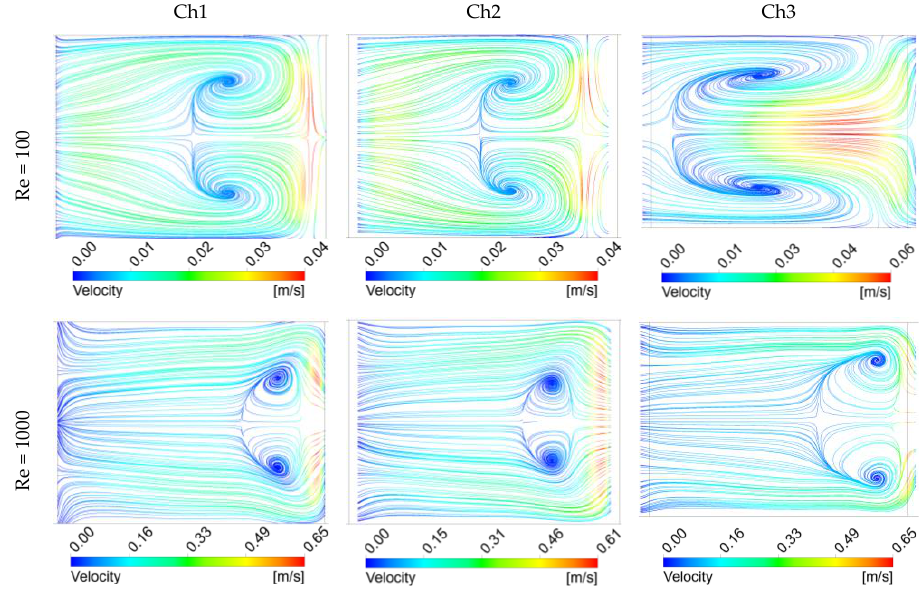
Figure 11. Velocity contours in the x – z axis.